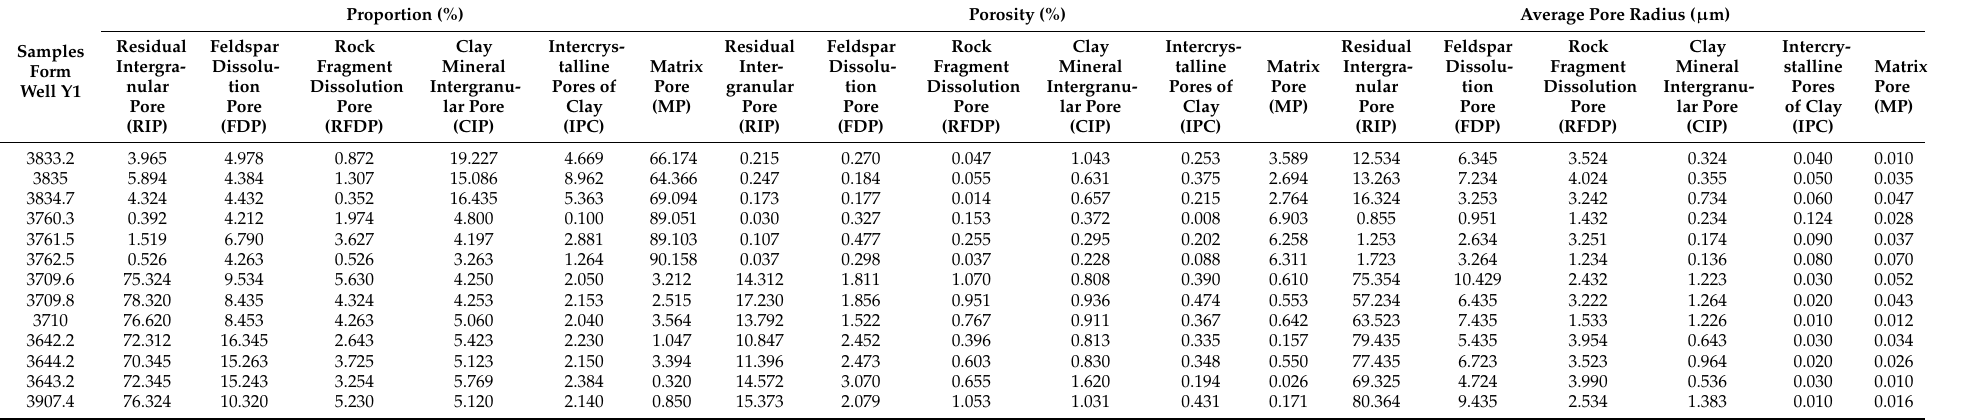
Table 2. The proportion, porosity, and average pore radius of different pore types in the Toutunhe Formation (Samples number: